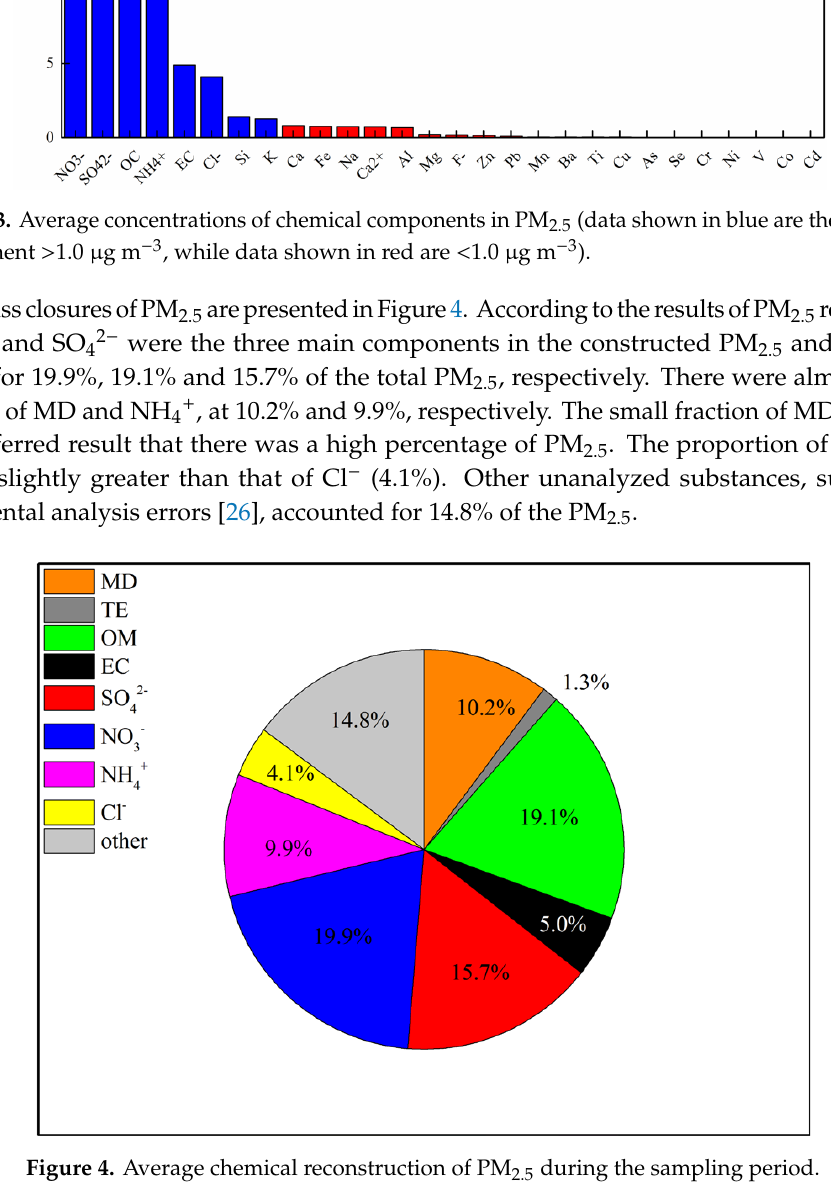
Figure 4. Average chemical reconstruction of PM 2.5 during the sampling period. Table 1. Average concentrations and chemical compositions of PM 2.5 during the sampling period.